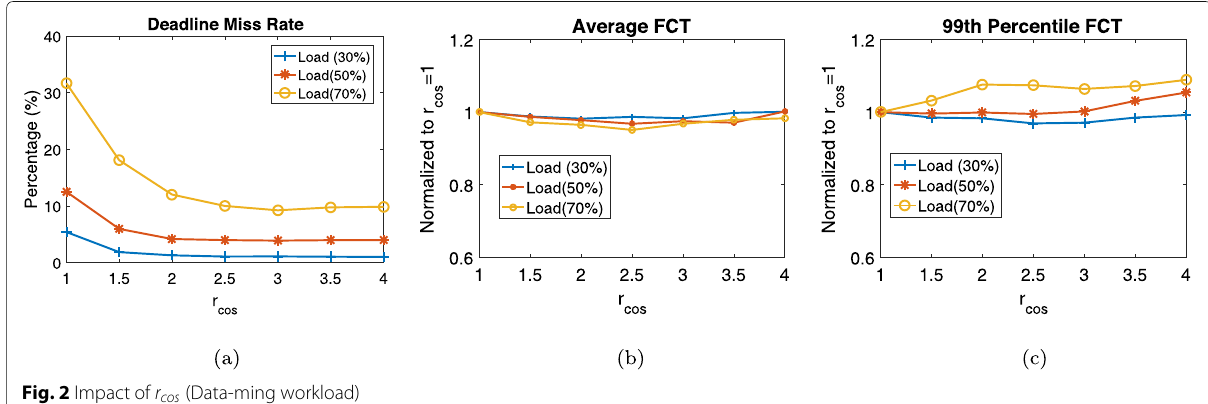
Fig. 2 Impact of r cos (Data-ming workload)